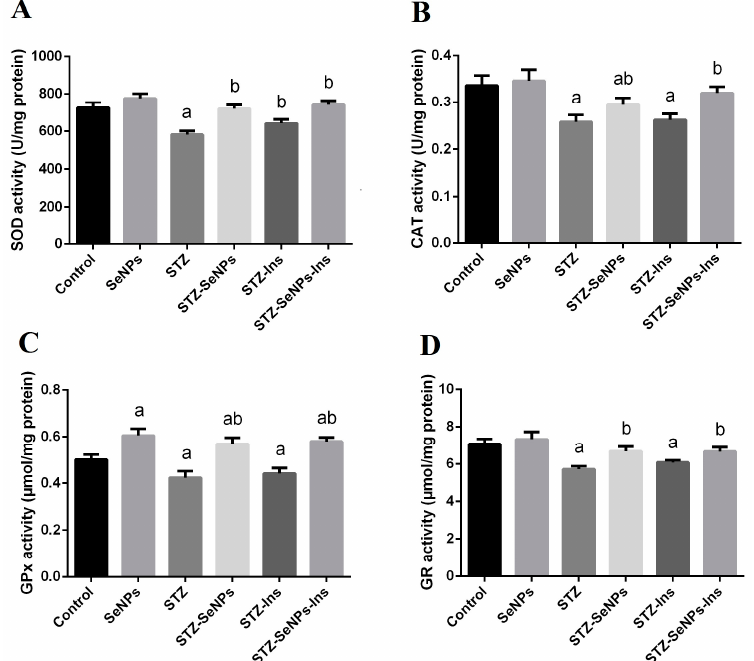
Figure 4. Effect of SeNPs and insulin on antioxidant enzyme activities [( A ) superoxide dismutase: SOD; ( B ) catalase: CAT; ( C ) glutathione peroxidase: GPx and ( D ) glutathione reductase: GR] in the testis of control and STZ-diabetic rats. Values are mean ± SEM ( n = 7). a p < 0.05, significant change with respect to Control group; b p < 0.05, significant change with respect to Diabetic group.